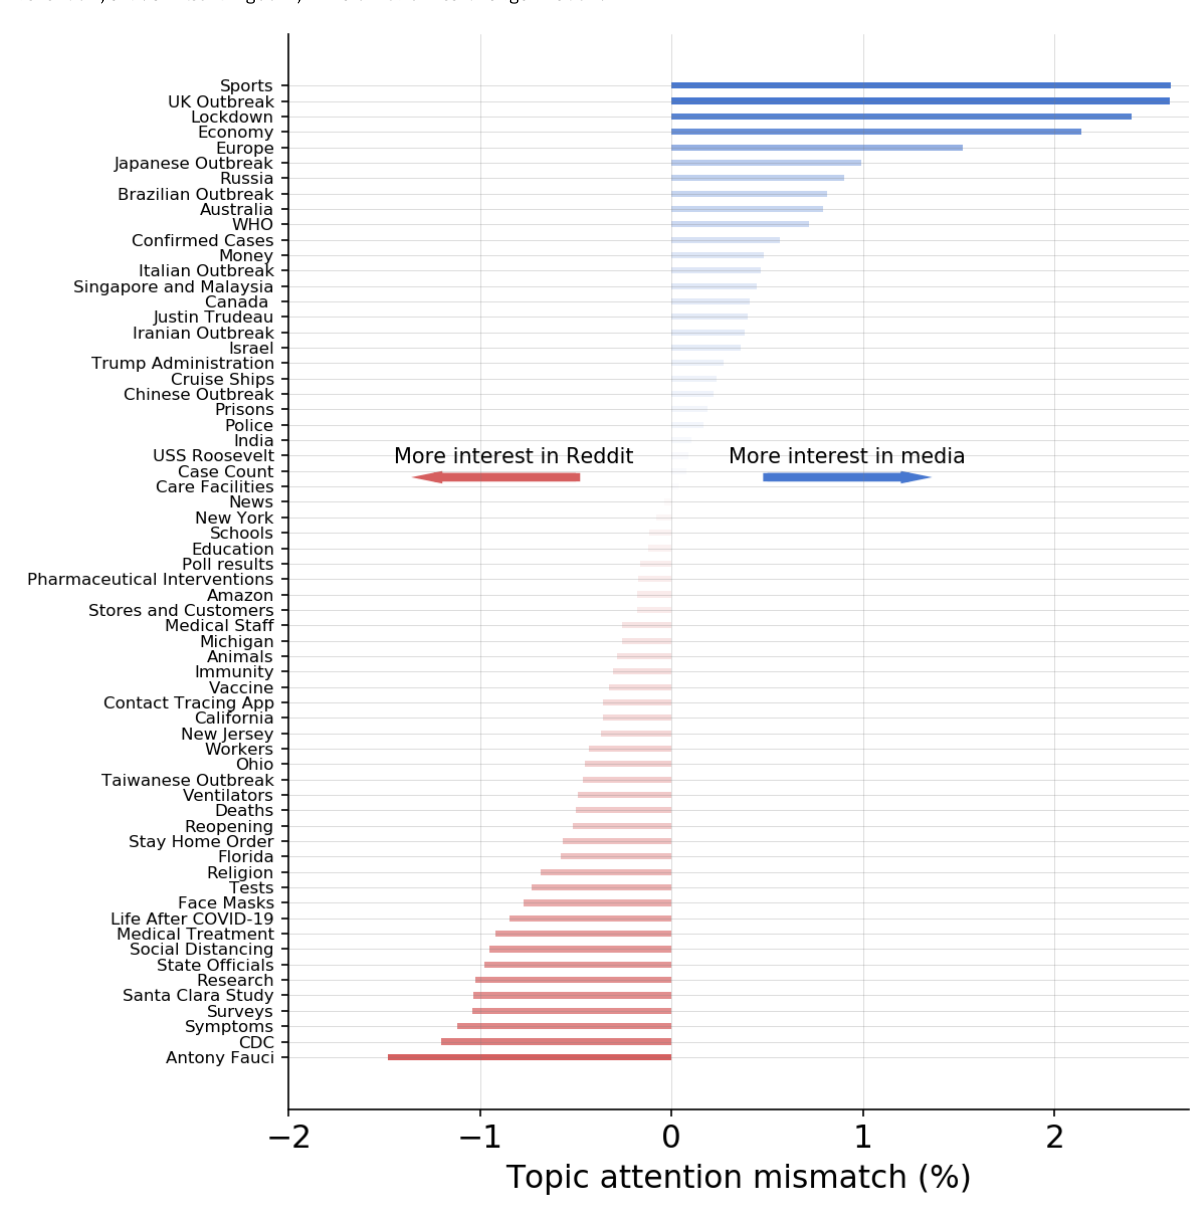
Figure 3. Differences in interest percentage shares of different topics by traditional media outlets and Reddit users. For example, +2% on the x-axis indicates that traditional media dedicates proportionally 2% more attention to that specific topic than Reddit users. CDC: US Centers for Disease Control and Prevention; UK: United Kingdom; WHO: World Health